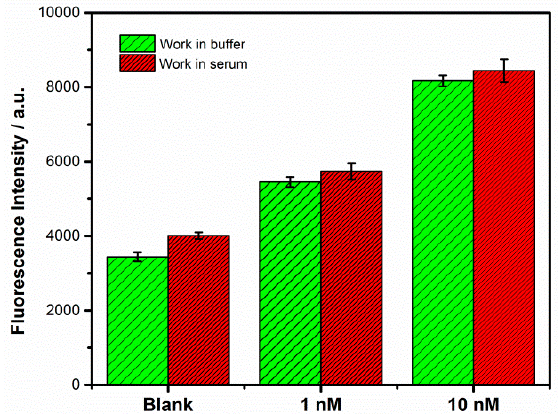
Figure 9. Results obtained from the fluorescent tests of Tris–HCl buffer and diluted serum samples